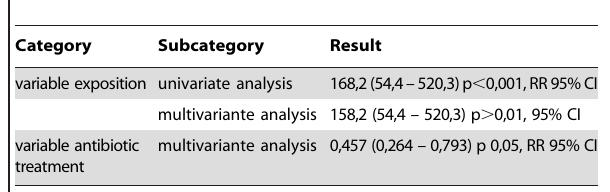
Table 4. Statistical analysis.